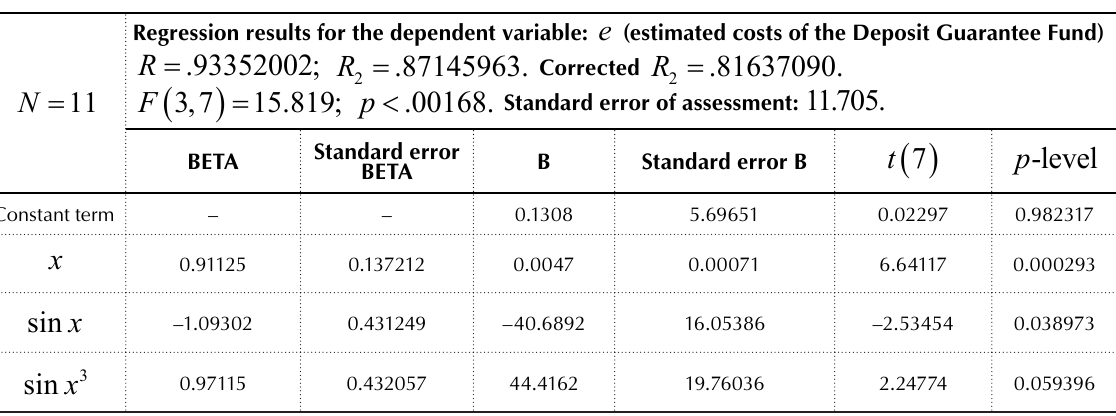
Table 4. The results of regression of the estimated costs of the Deposit Guarantee Fund ( ) e from its volume ( ) x Regression results for the dependent variable: e (estimated costs of the Deposit Guarantee Fund) .93352002; R = 11 N =